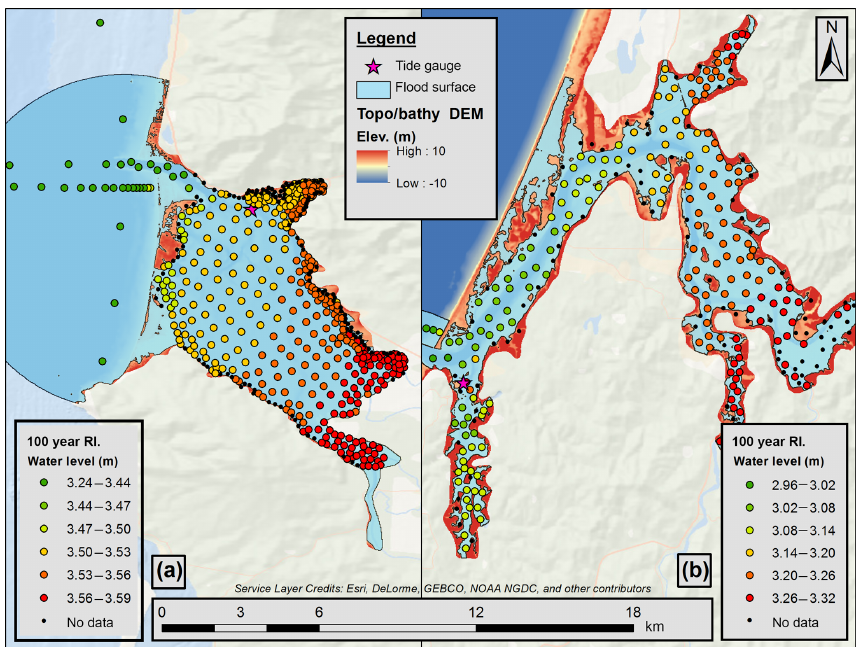
Figure 7. Historic period 100-year flood surface results for Tillamook (a) and Coos (b) bays. Individual stations are plotted with color scale indicating the modeled 100-year-RI WL magnitude for the historic period. Note that the color scale is different between the two study sites. The calculated flood inundation surface is plotted as a blue transparent